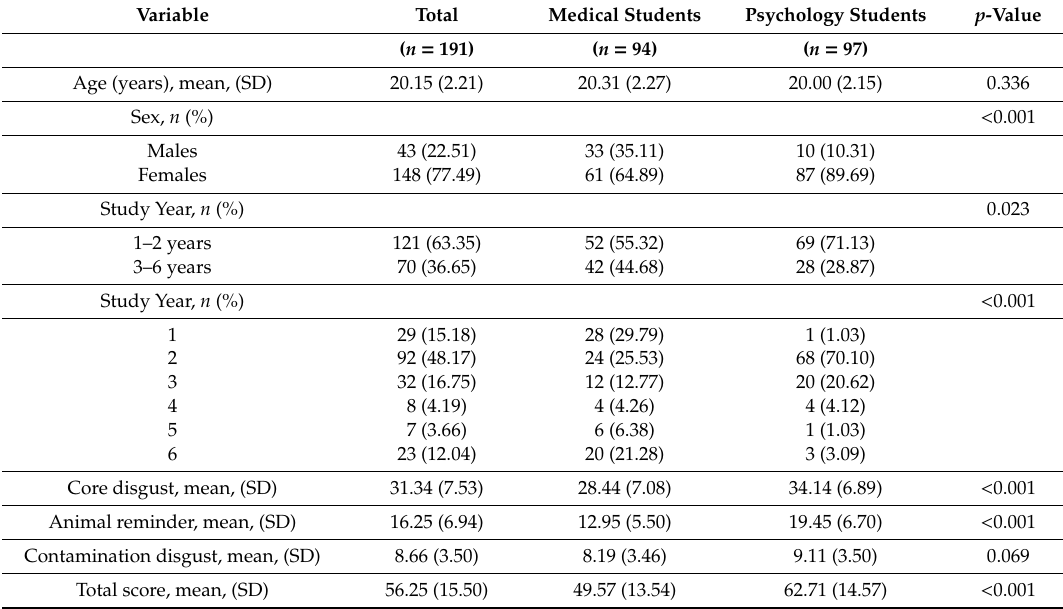
Table 1. Demographic characteristics and disgust scale—revised DS-R scoring in the total number of participants and according to